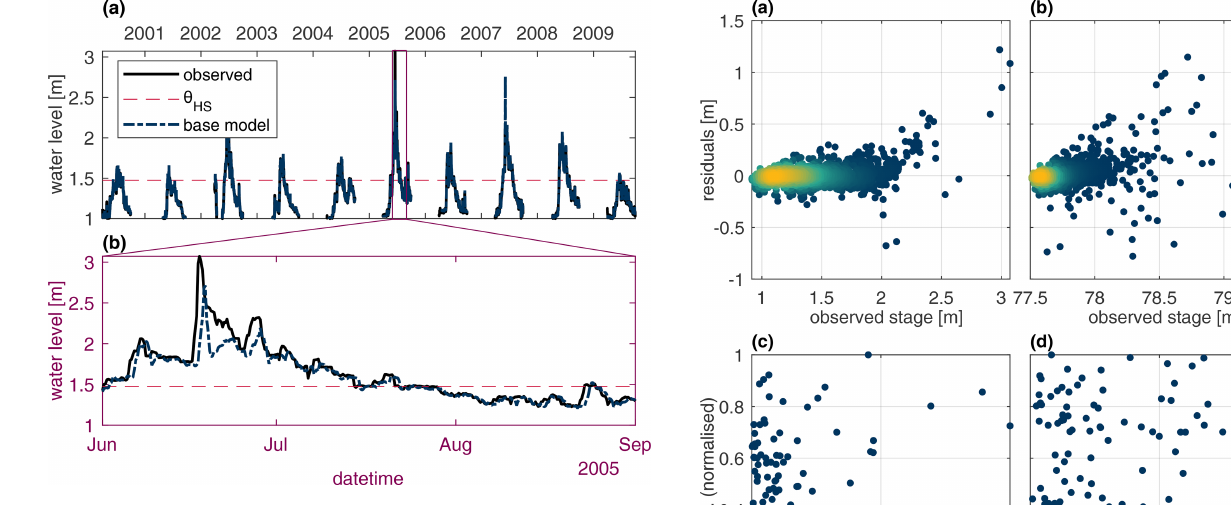
Figure 3. Observed and individual learner stage predictions for the Bow River system for all 10 years of an available stage (a) and a 3-month subset which contains a particularly high stage (b) to better distinguish between the two hydrographs. The dashed red line indicates the fixed threshold used to distinguish between typical and high stage values.